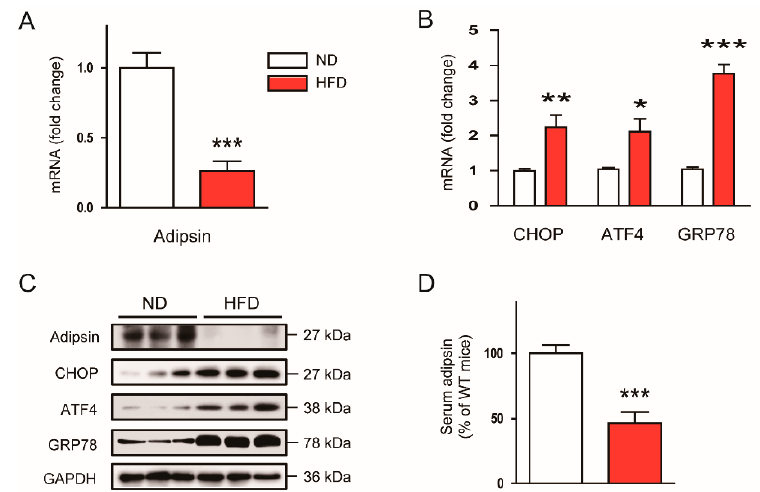
Figure 3. Chronic ER stress downregulates adipsin expression in vivo. C57BL/6N mice were fed a normal chow diet (ND) or a high-fat diet (HFD) for 12 weeks. ( A ) Real-time RT-PCR analysis of adipsin in gWATs. ( B ) Real-time RT-PCR analysis of CHOP, ATF4, and GRP78 in gWATs. ( C ) Western blot analysis of adipsin, CHOP, ATF4, GRP78, and GAPDH in gWATs. GAPDH was used as a loading control. Each lane represents an individual animal. ( D ) Serum levels of circulating adipsin. n = 8 per group. All data are represented as the mean ± SEM. * p < 0.05, ** p < 0.01, and *** p < 0.001 vs. ND-fed group.